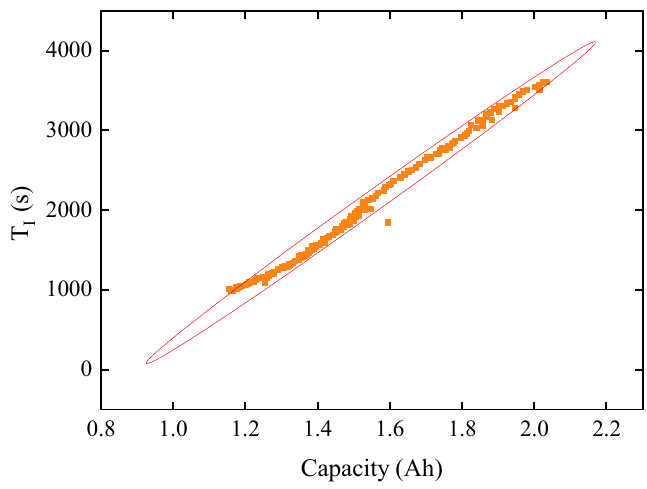
Figure 4. Scatter figure of T I .